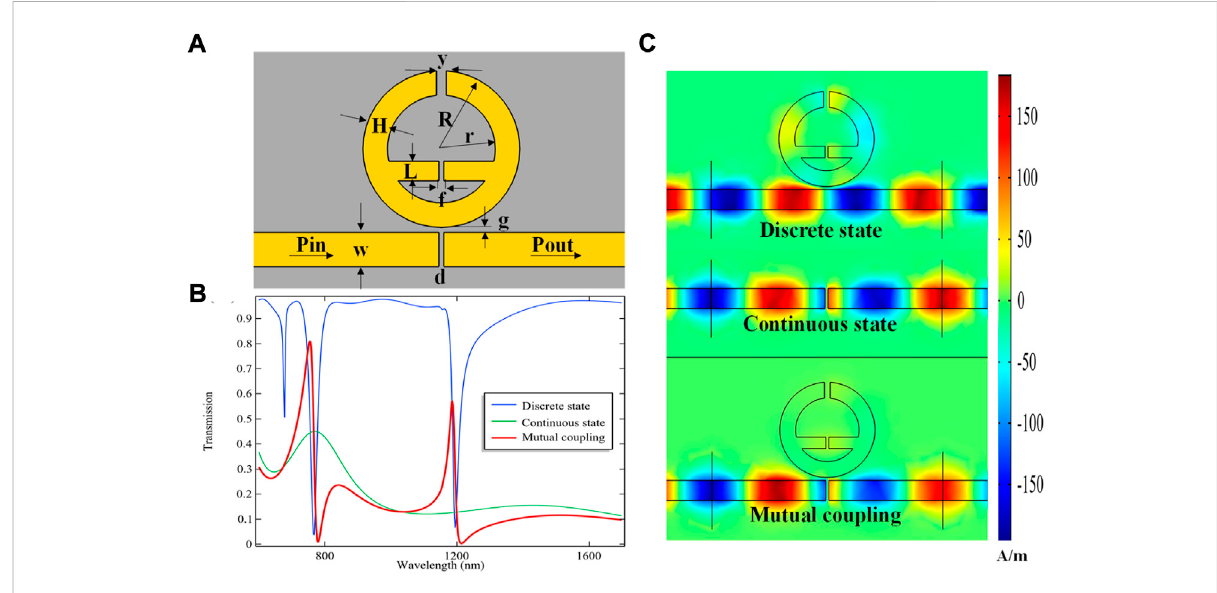
FIGURE 1 (A) The waveguide structure composed of a BW and a CSRR, (B) Transmission lines of the entire structure (C) the magnetic fi eld distributions in the discrete state, continuous state, and mutual coupling.